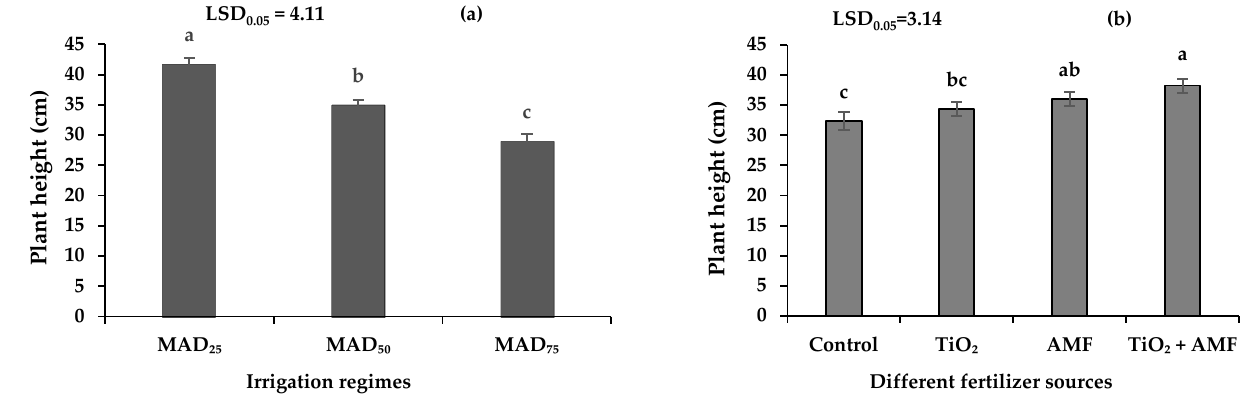
Figure 2. The plant height of sage in different irrigation regimes ( a ) and fertilizer sources ( b ). MAD 25 , MAD 50 , and MAD 75 indicating non-stressed, moderate, and severe drought stress, respectively. AMF: arbuscular mycorrhizal fungi; TiO 2 : titanium dioxide nanoparticle. Different letters indicate significant differences at the 5% level according to LSD test.